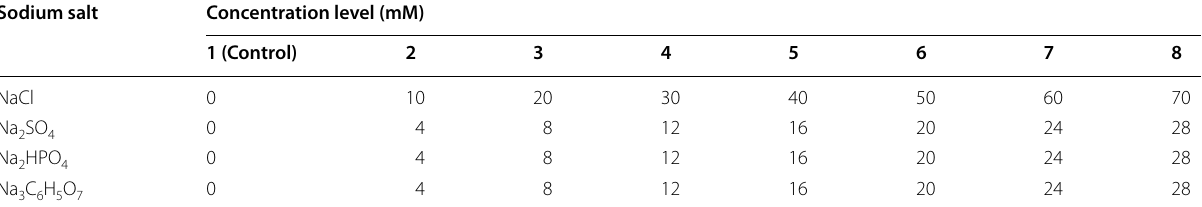
Table 1 The type and concentration level of sodium salts Sodium